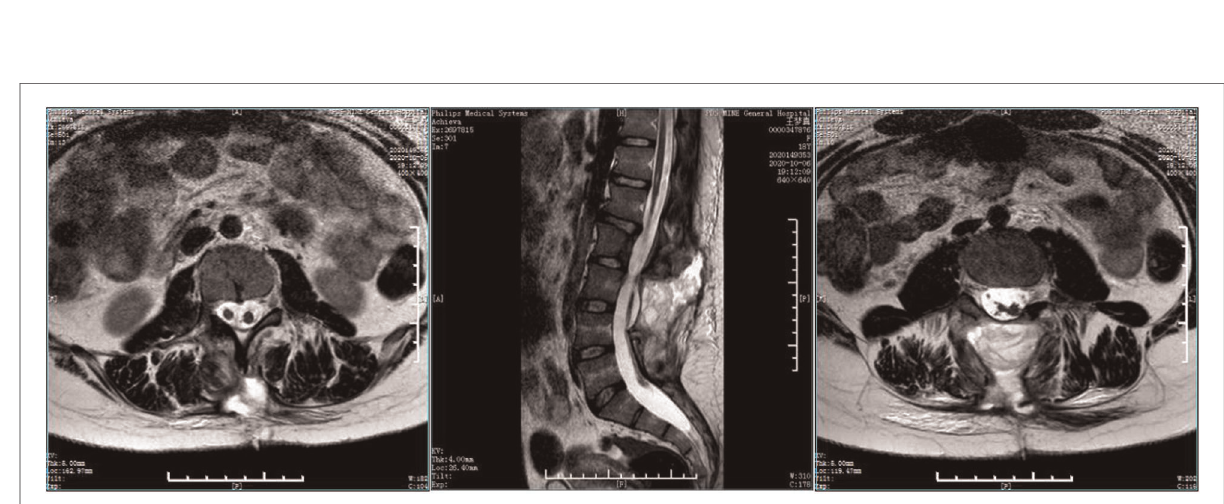
FIGURE 9 Postoperative MRI. The compression of the spinal cord was removed, with diastematomyelia and tethered cord, without fusion of the L4-5 vertebral arches.